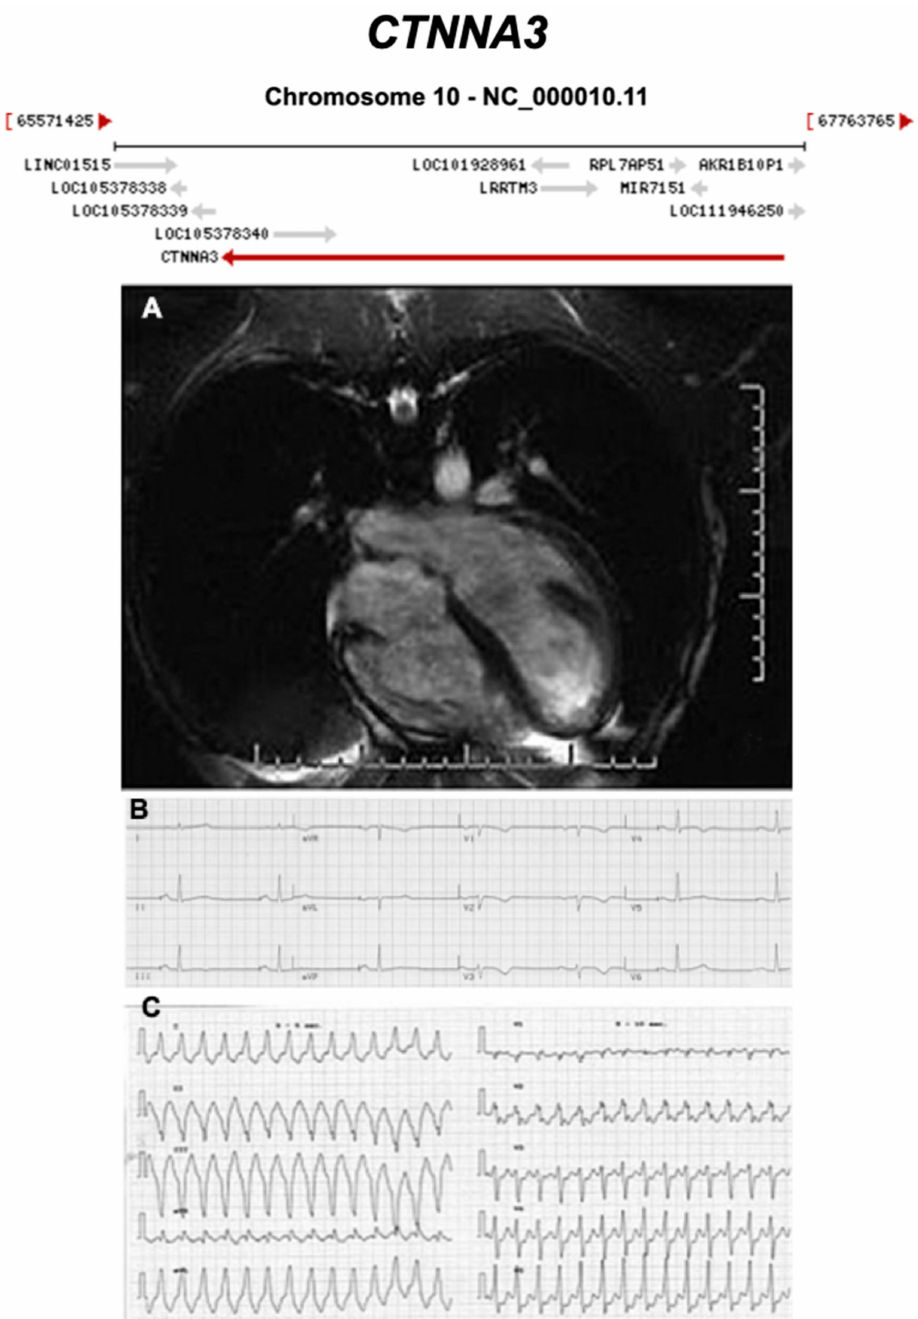
Figure 14. Exemplar MRI and ECG finding found in ACM patients with CTNNA3 mutations. ( A ) CMR of a patient with CTNNA3 p.val94asp mutation showing marked right ventricular dilatation; ( B ) 12-lead ECG of the same patient showing a first degree heart block and T-wave inversion in V1–V4; ( C ) sustained ventricular tachycardia, with left bundle-branch block and left axis deviation. Reproduced with permission from van Hengel et al. (2013)